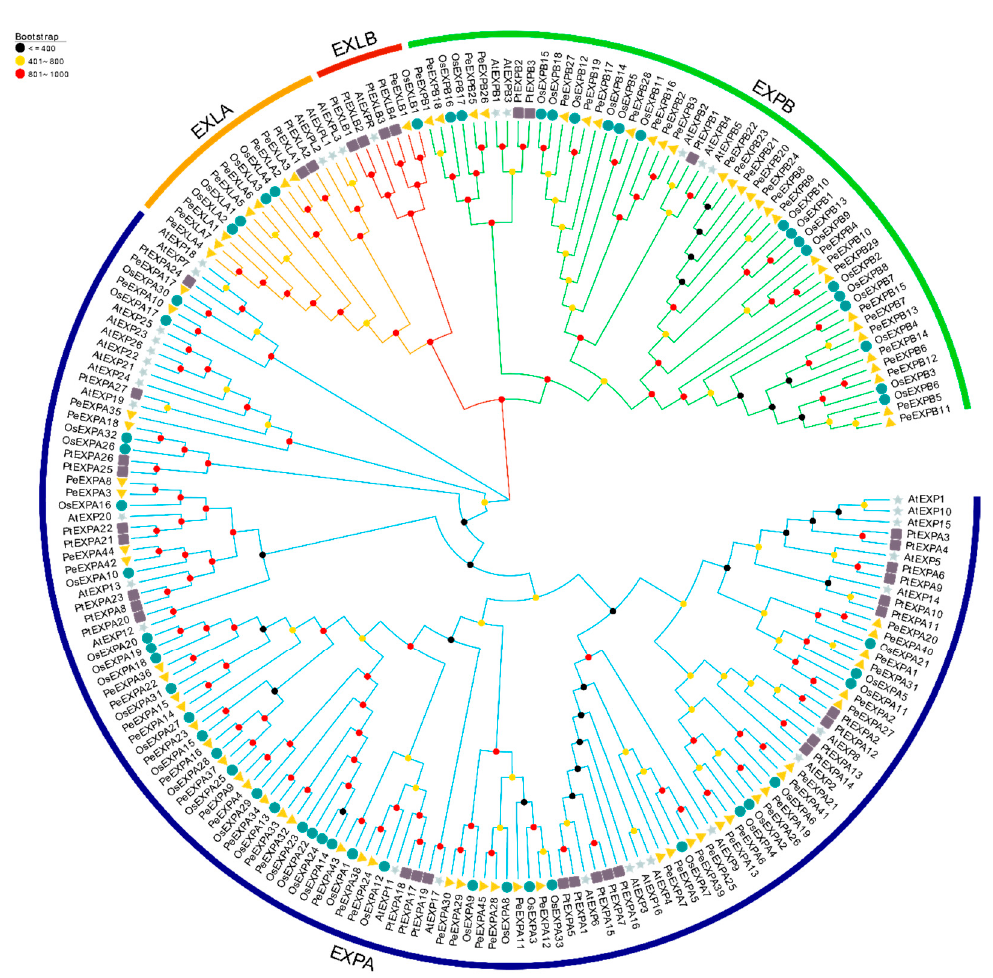
Figure 1. Phylogenetic tree of expansins from moso bamboo, rice, Arabidopsis and poplar. MEGA7.0 was used to construct a neighbor-joining (NJ) phylogenetic tree with 1000 bootstrap replications. Triangles, circles, stars and squares represent the expansins of moso bamboo, rice, Arabidopsis and poplar, respectively. Different ‐ colored circles on the branches represent bootstrap values.